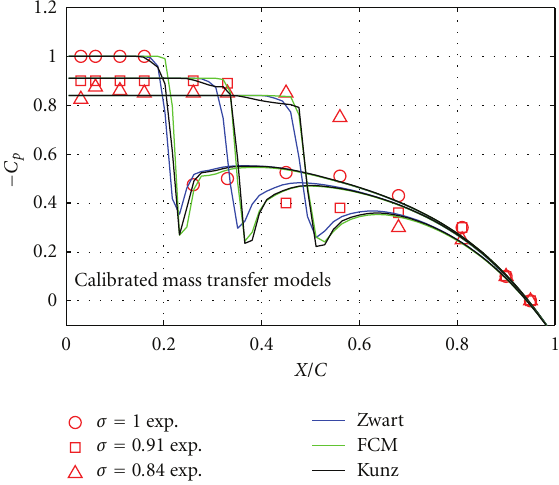
Figure 5: NACA66(MOD) hydrofoil at AoA = 4 o , Re = 2 × 10 6 . Suction side pressure distributions computed using noncalibrated Zwart, FCM, and Kunz mass transfer models.